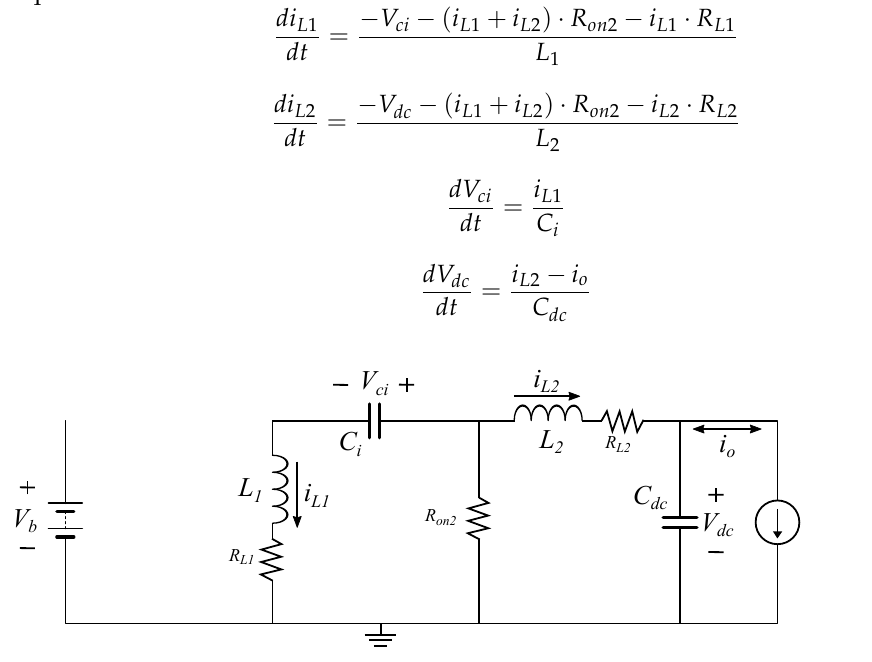
Figure 4. Charger/discharger operation for u =